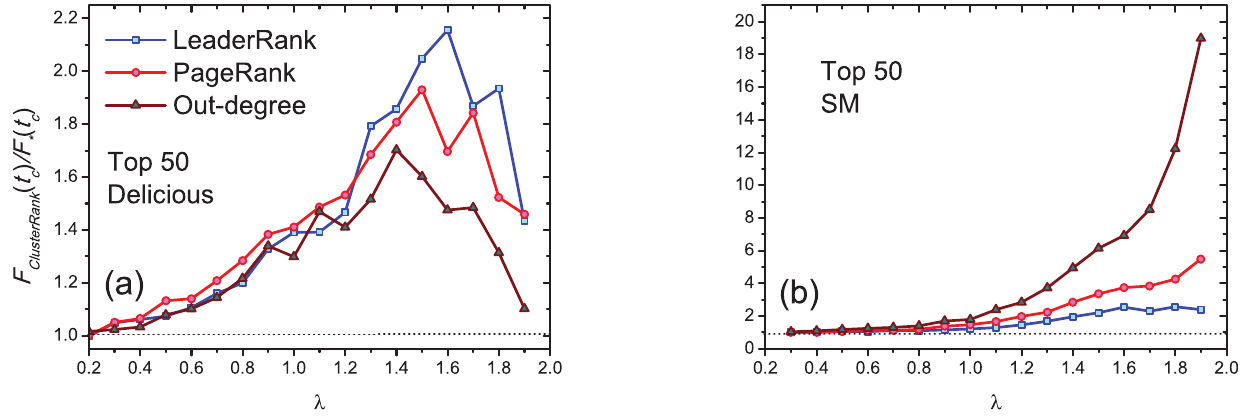
Figure 7. The ratio of the number of final recovered nodes by ClusterRank to those by out-degree centrality, PageRank and LeaderRank. The non-overlapped nodes in the top-50 lists are initially infected. We set b ~ 1 = S k out T . Each data point is obtained by averaging over 100 independent runs.